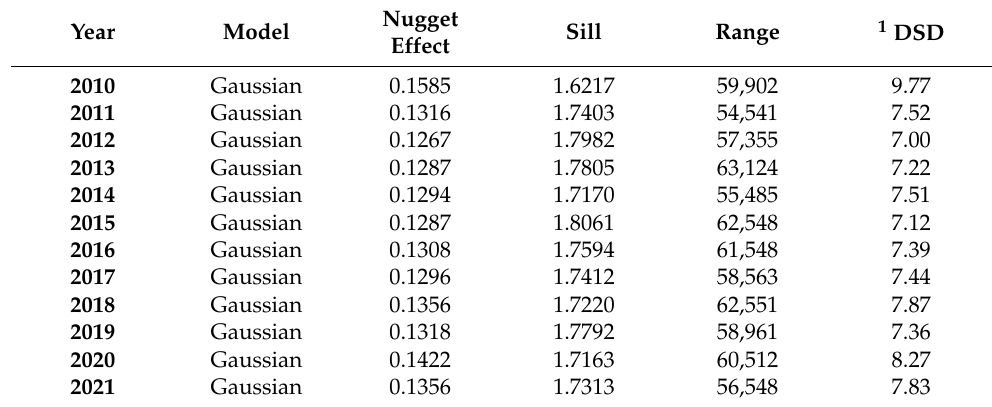
Table 3. Parameters for the fitted semivariogram models and Degree of Spatial